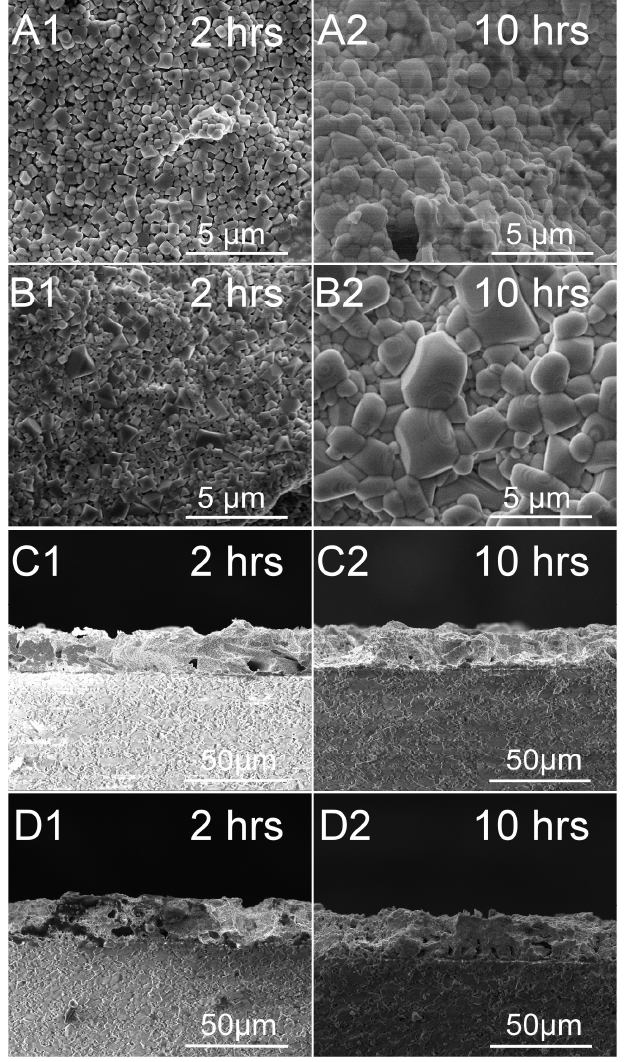
Figure 3. SEM surface and cross-sectional images of ITO and In 2 O 3 films with 8 wt % glass additives annealed at 1250 °C with different measuring times. ( A , C ) ITO film; ( B , D ) In 2 O 3 film.